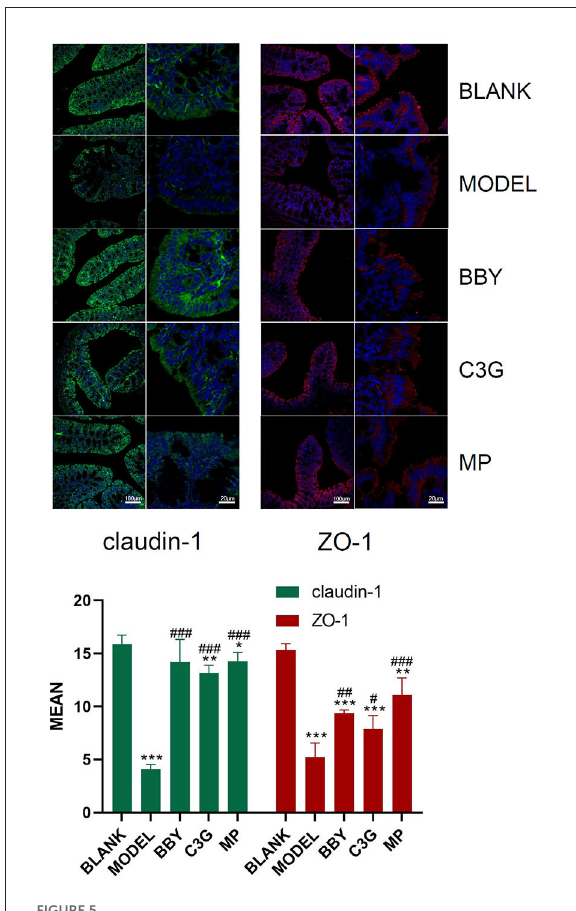
FIGURE5 Representative images of immunofluorescence of claudin-1 and ZO-1. Green fluorescence is claudin-1, red fluorescence is ZO-1, and blue fluorescence is DAPI staining. The figure below is a quantitative comparison of the fluorescence intensity calculated by ImageJ. *Indicated a significant difference compared with the BLANK group, # indicated a significant difference with the MODEL group, where * p < 0.05, ** p < 0.01, *** p < 0.001; # p < 0.05, ## p < 0.01, ### p < 0.001.